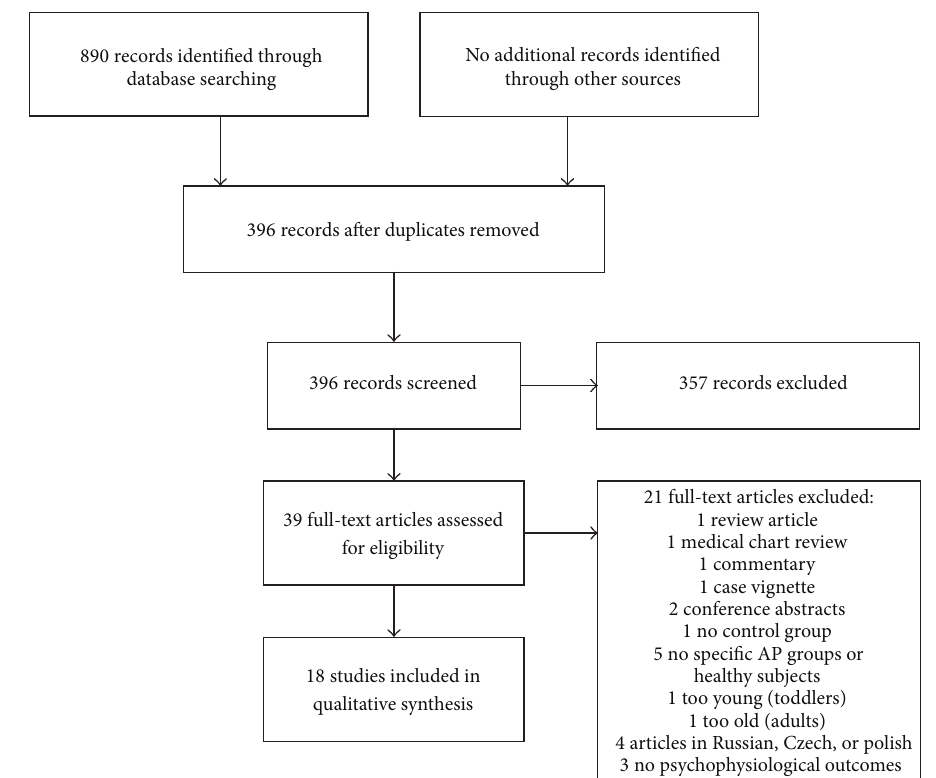
Figure 1: Procedure and results of the paper search and